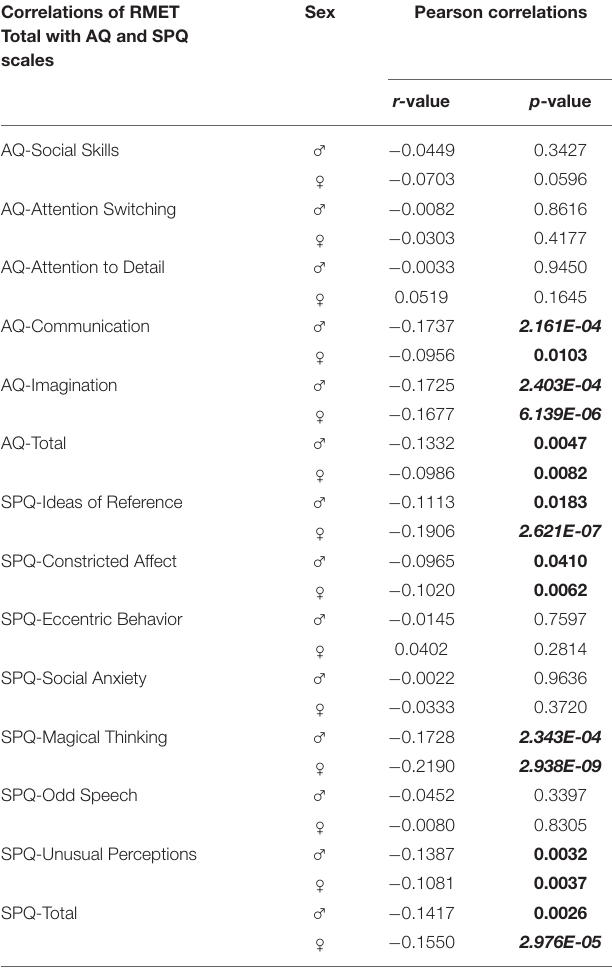
TABLE 3 | Pearson product-moment correlations of RMET Total with AQ and SPQ-BR scales. Correlations of RMET Total with AQ and SPQ